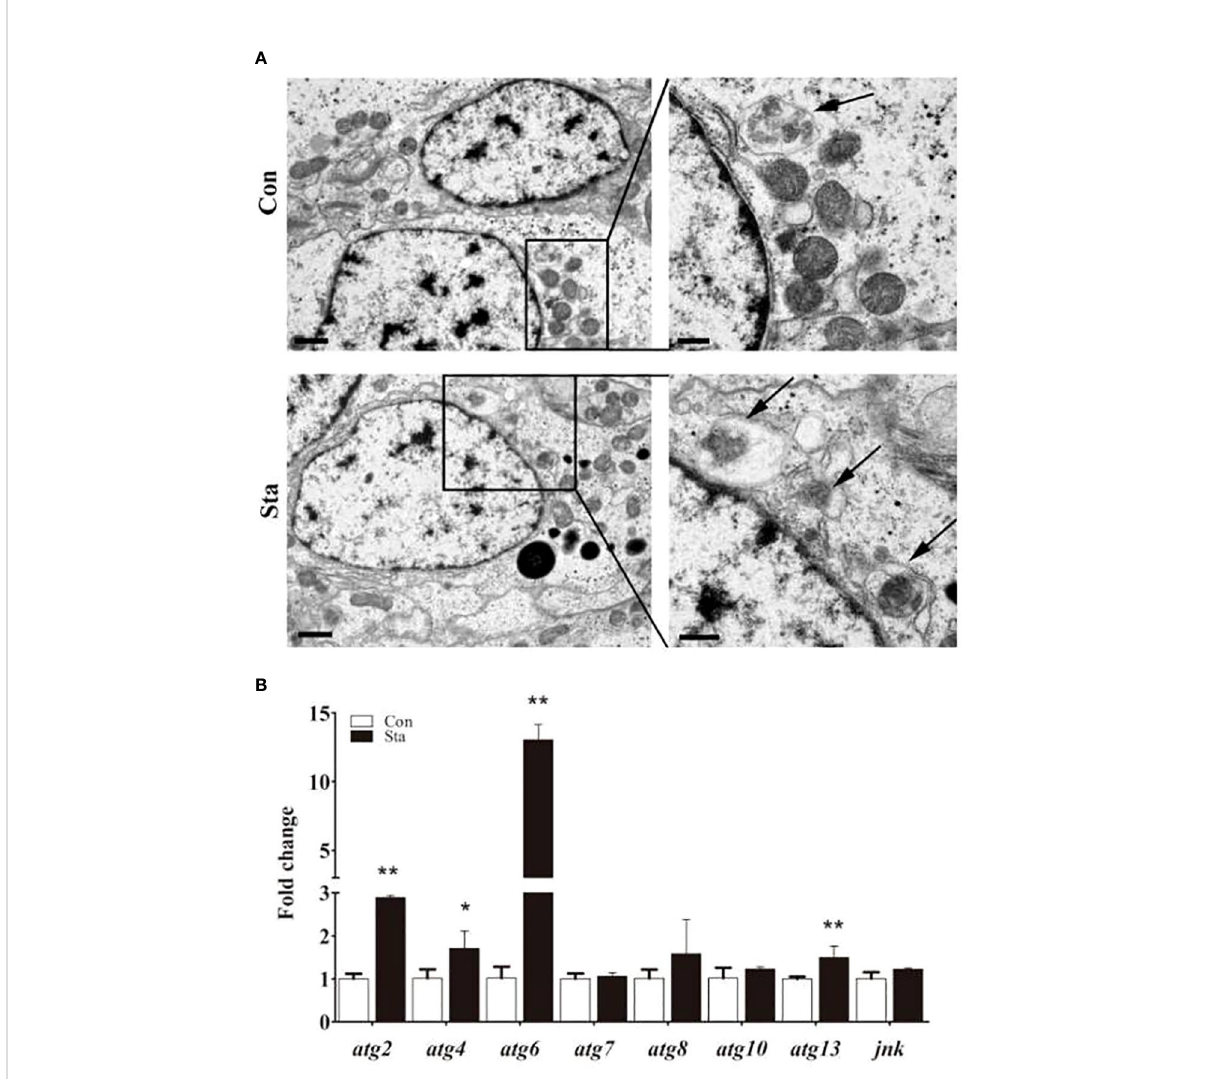
FIGURE 5 Autophagosome transmission electron microscope (A) and autophagy gene expression (B) . ATG mRNA expression levels in mussel gill were detected by qRT-PCR. Values are shown as means ± SD (n=3), * P <0.05 or ** P <0.01 versus Con